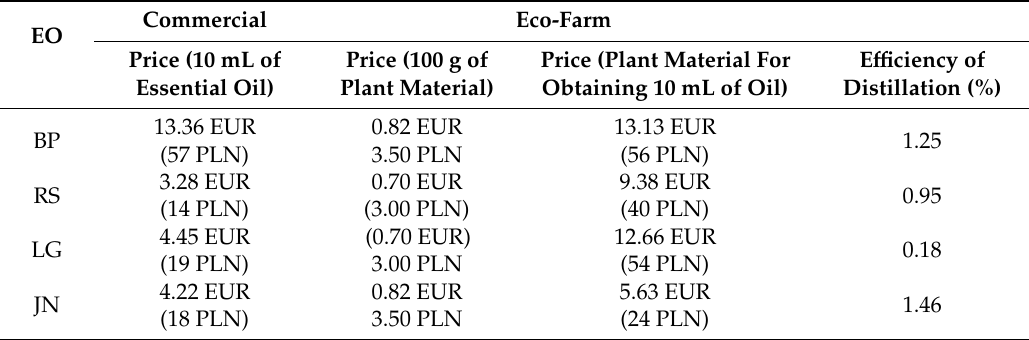
Table 1. Production capacity of essential oil of plant material and a list of cost of obtaining 10 mL of oils (on the Polish market in July 2019; the currency exchange rate as of 12 June 2019).